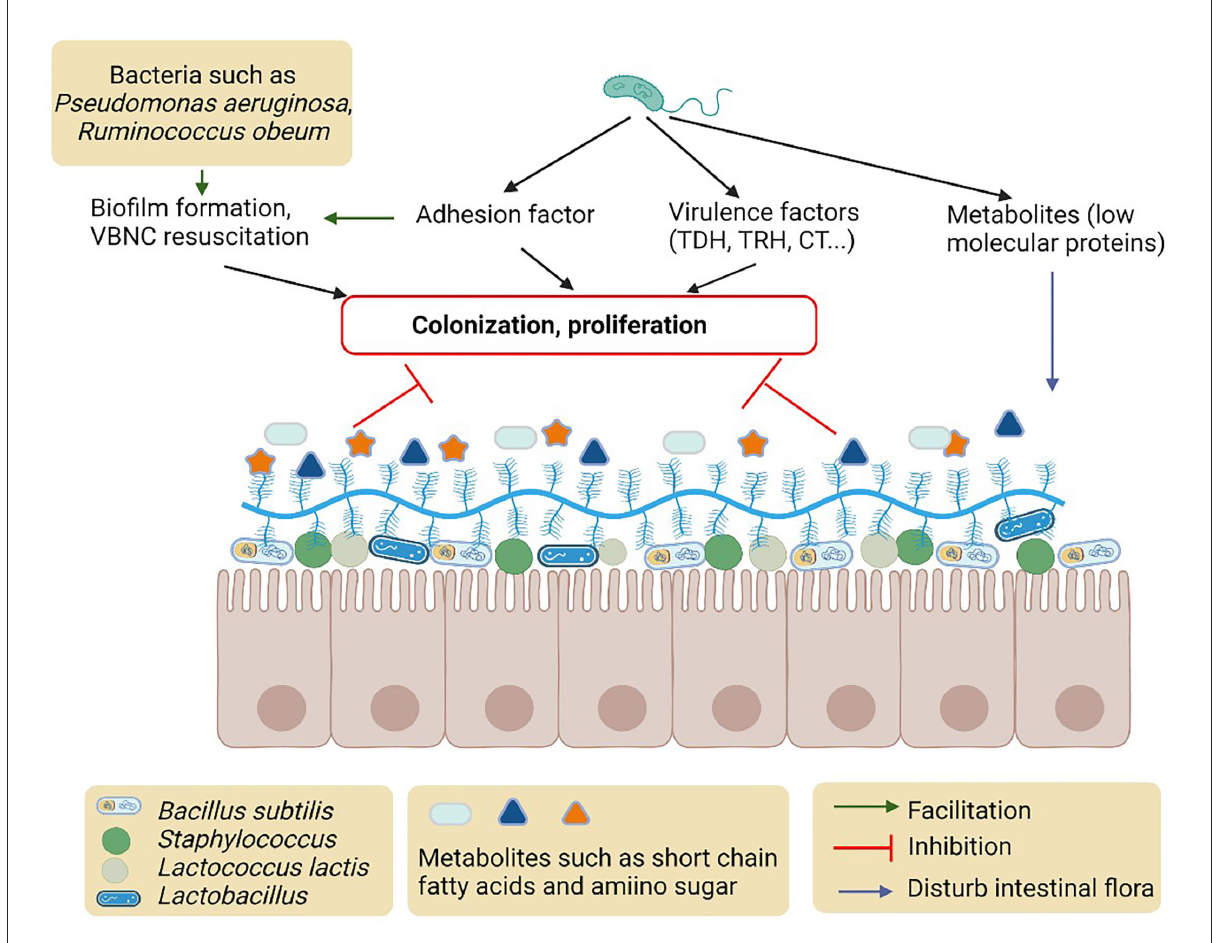
FIGURE2 Possible mechanisms and metabolites of intestinal microbiota to inhibit colonization of proliferation of Vibrio .